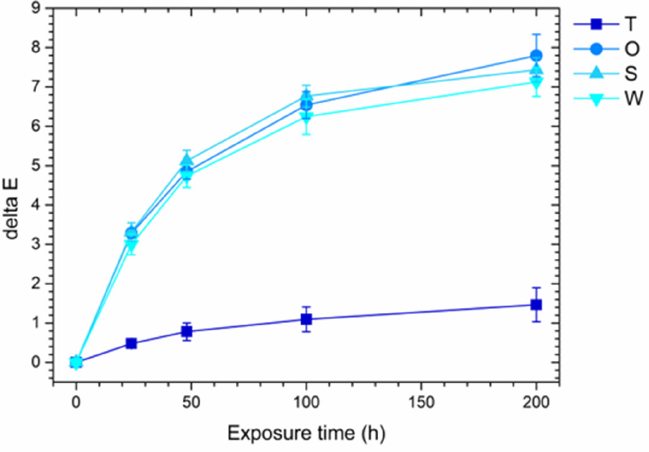
Figure 11. Total color variation during UV-B exposure.